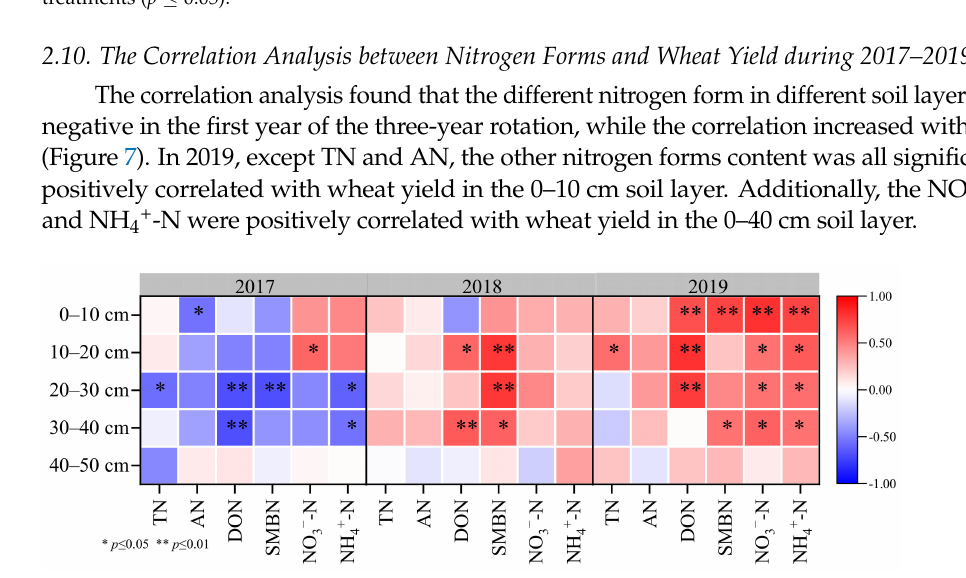
Figure 7. The correlation between nitrogen forms and wheat yield under different soil